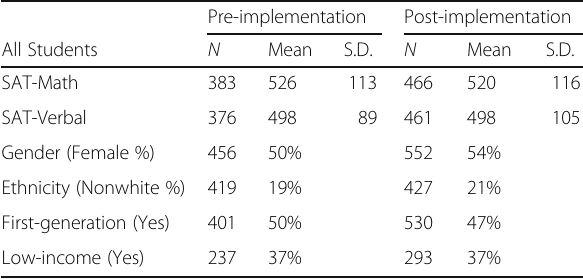
Table 2 SAT scores and demographic factors for students pre- and post-implementation. N refers to the number of students for whom data on each factor was available, and the percentage listed is that fraction of the sample for the category listed. No pre- to post-implementation differences were statistically